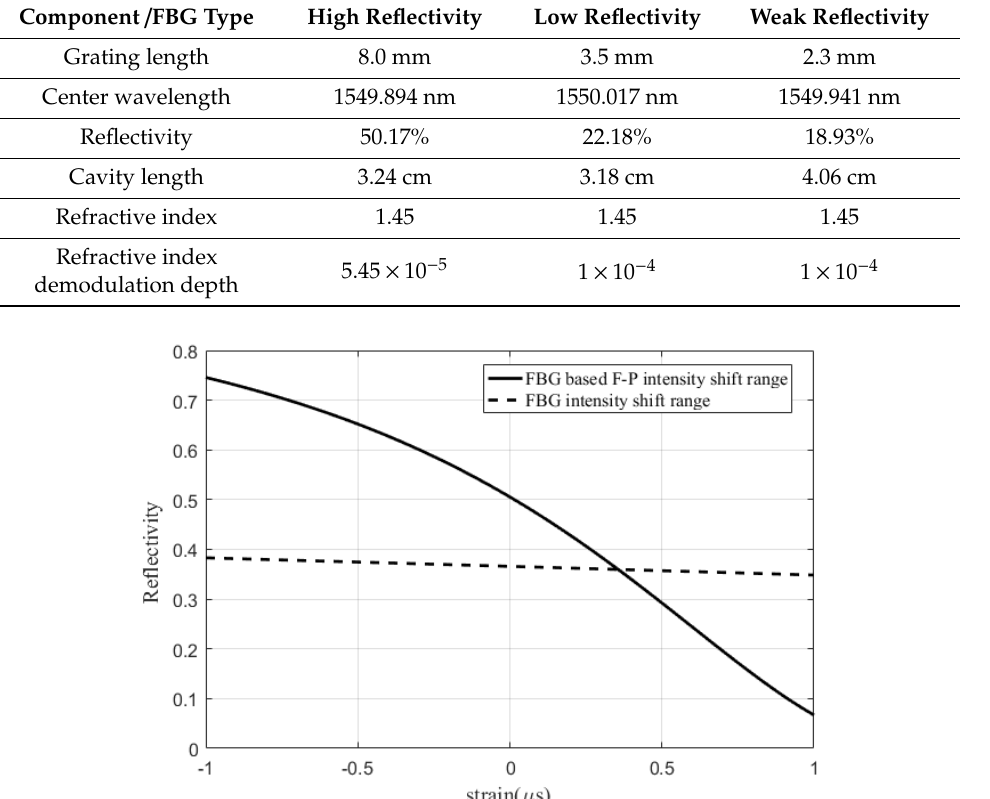
Table 2. FBG-based FP sensor parameters.